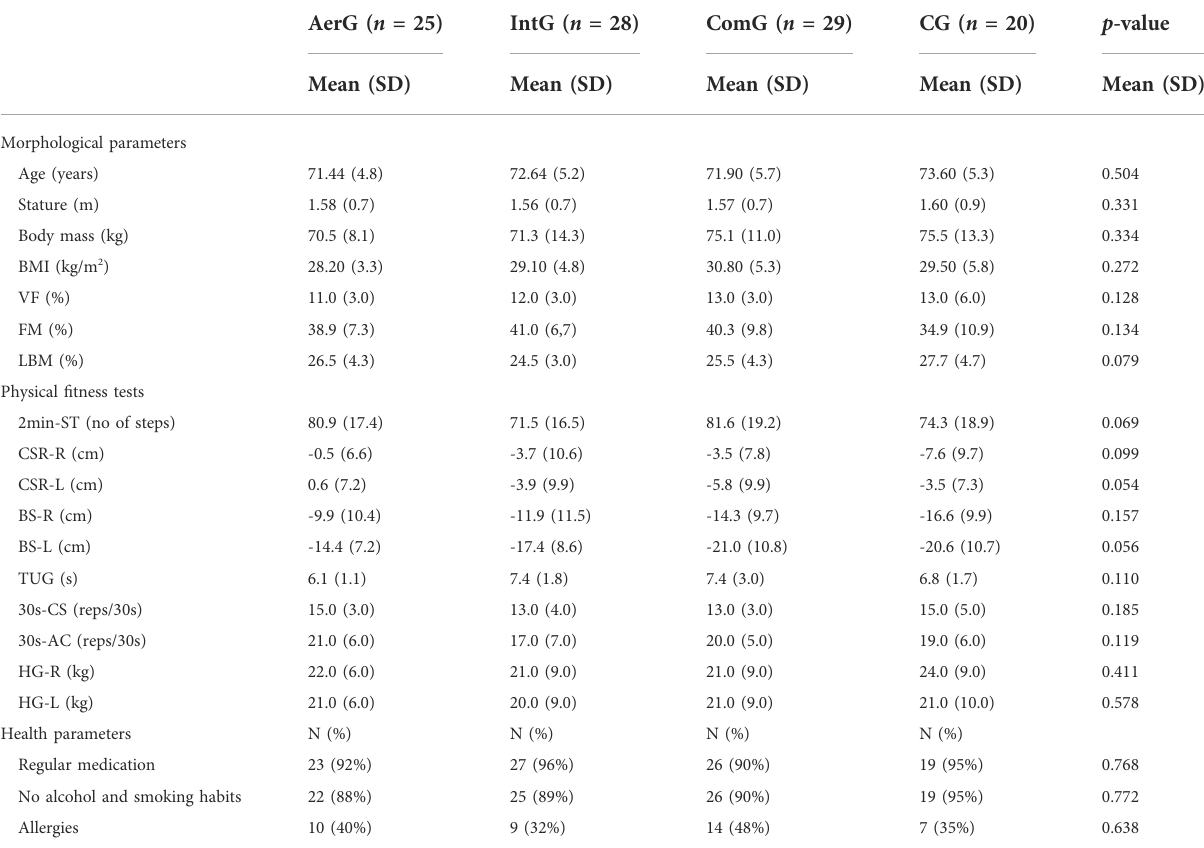
TABLE 1 Participant ’ s baseline characteristics by